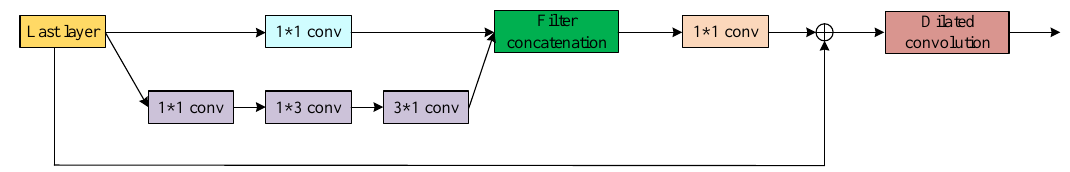
The general structure of the convolution block used in the nodule candidate detection sub-network.